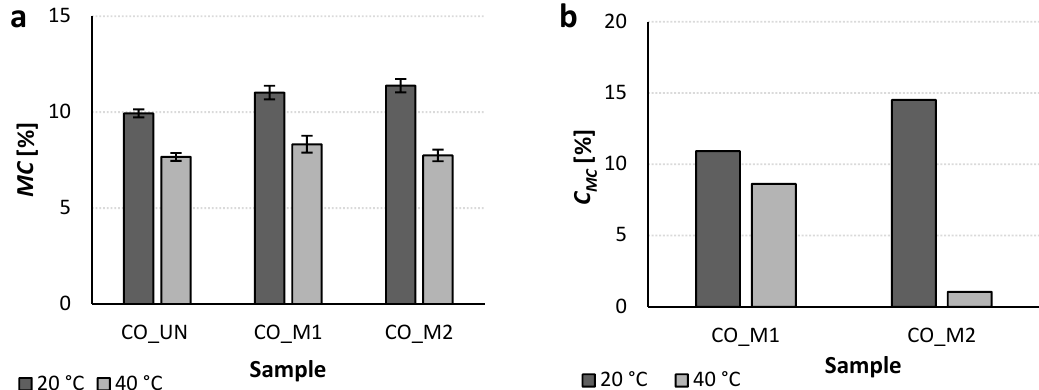
Figure 8. ( a ) Moisture content (MC) of the studied samples, determined after preconditioning at 20 or 40 °C and 65% ± 2% relative humidity for 24 h; ( b ) contribution of the hydrogels ( C MC ) calculated from the MC values.